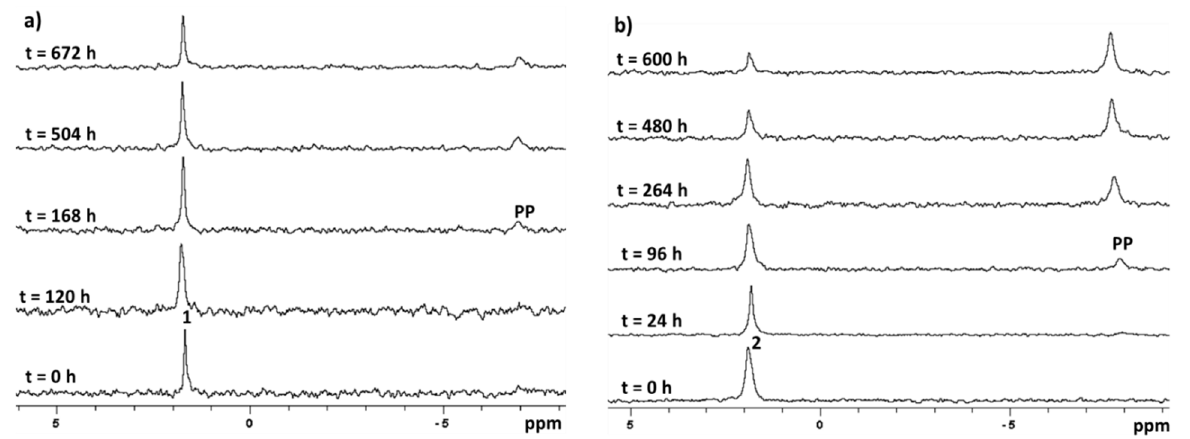
Figure 7. 31 P NMR (121.5 MHz) spectra at different times of 1 ( a ) and 2 ( b ) in acidic conditions (D 2 O, HEPES buffer 50 mM, pH* = 6.5, 120 mM NaCl, 37 ◦